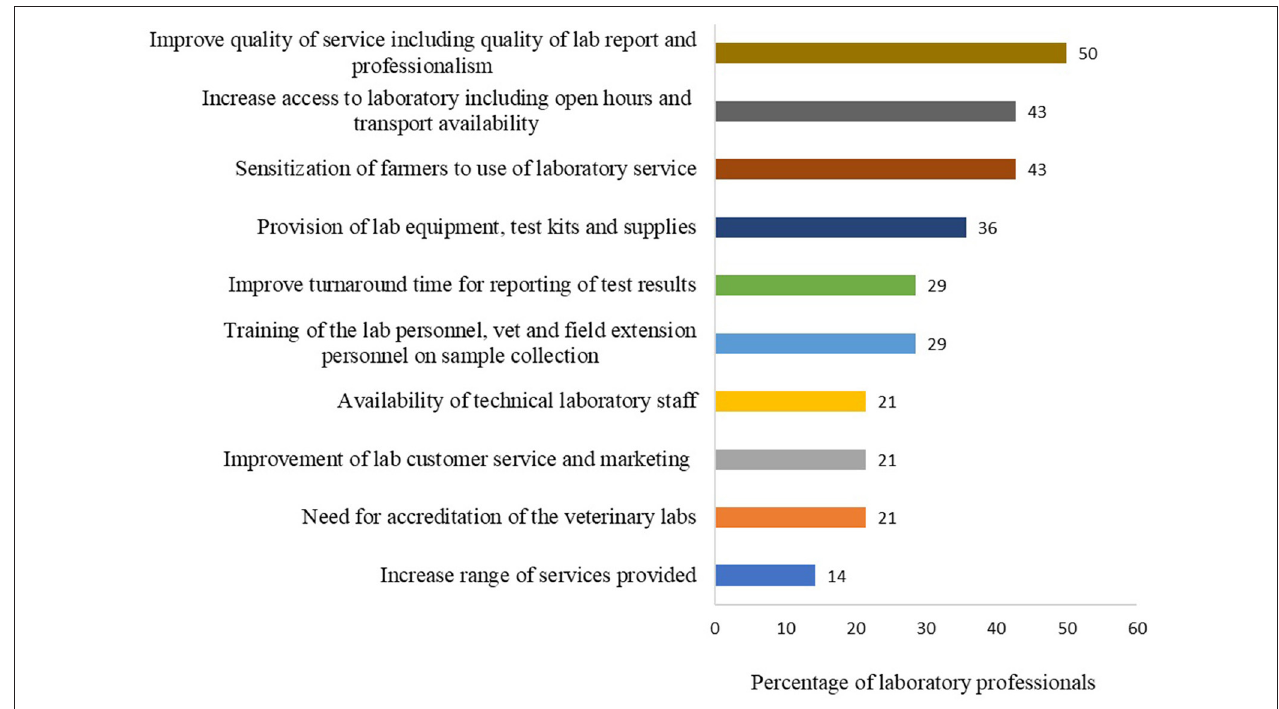
FIGURE 9 | Key aspects that the laboratory needs to improve to attract more clients and improve client satisfaction. Bars represent percent of laboratory technicians ( n = 14) that provided each solution. This question had multiple responses.